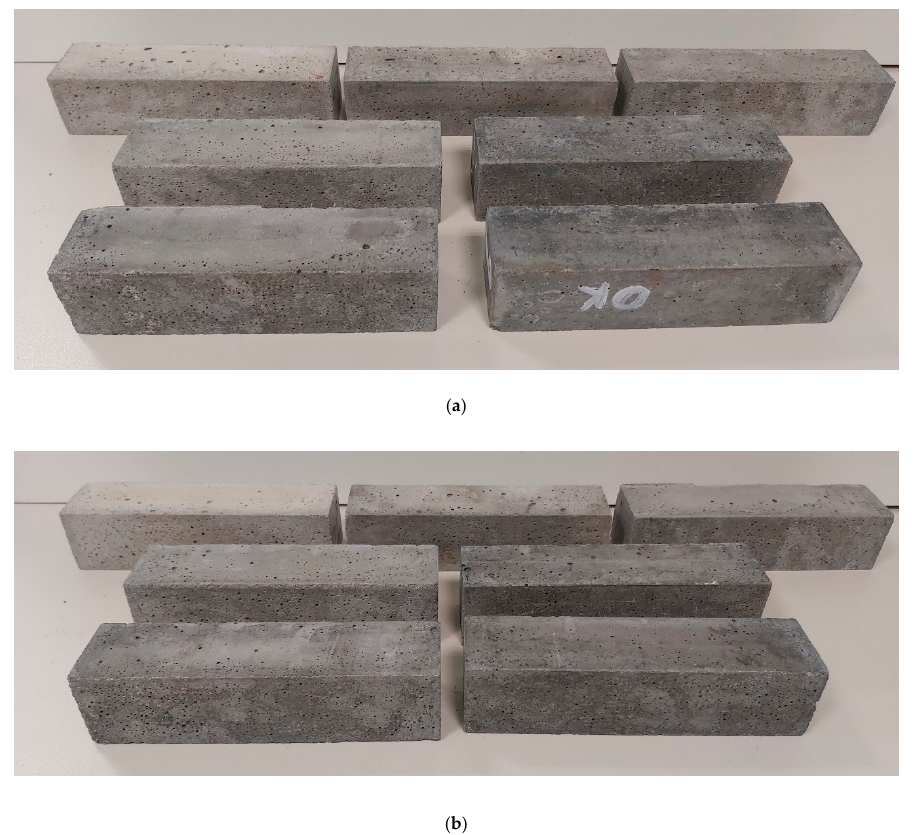
Figure 2. Sets of as prepared CNT- ( a ) and GNP-modified ( b ) mortars at different concentrations. The degree of nano- inclusion concentration is perceived as varying level of darkness of the actual mortar.